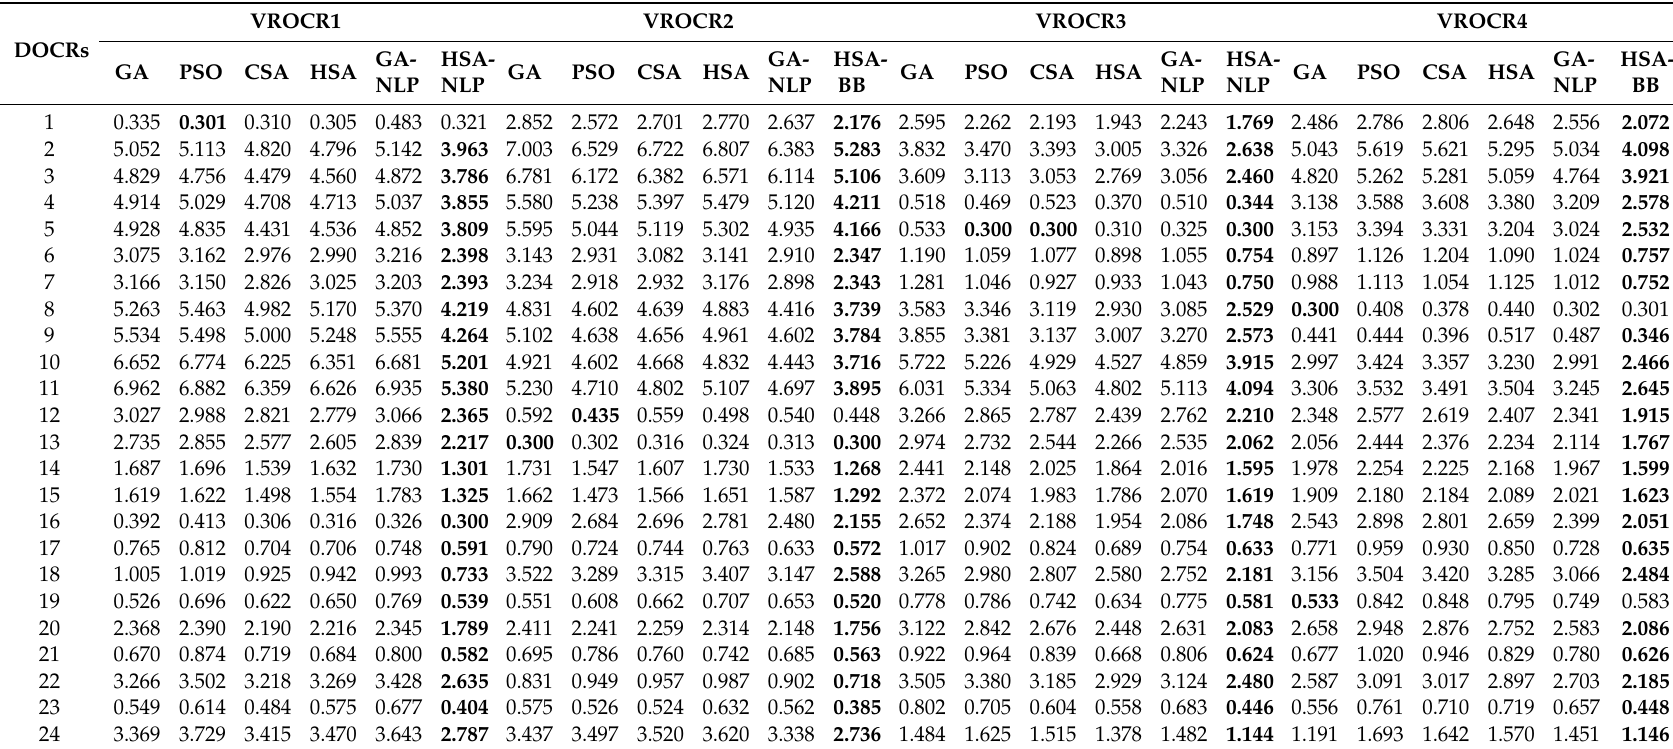
Table 10. CTI of P / B DOCRs-VROCRs pairs for 9-bus